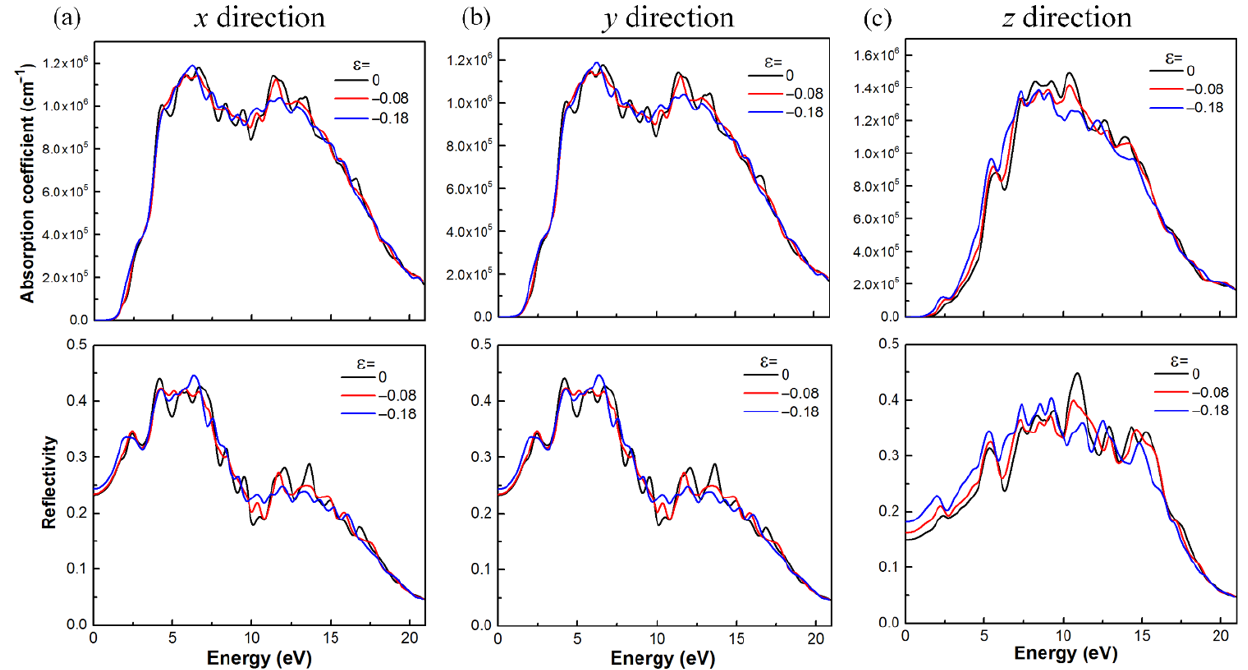
Figure 5. Absorption coefficient and reflectivity in the ( a ) x direction, ( b ) y direction, and ( c ) z direction of BlueP/WSe 2 vdW heterostructure under different compressive strains.